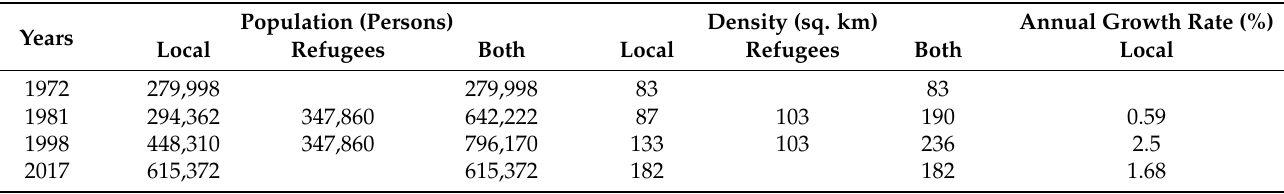
Table 5. Population statistics of District